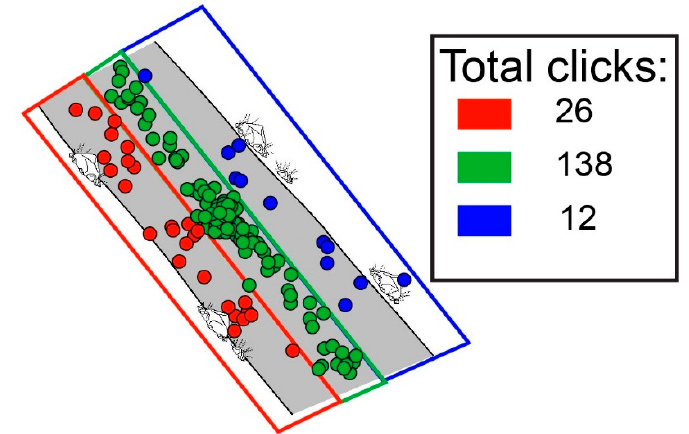
Figure 10. Polygons and student clicks in response to the prompt, “Click in the river where you would find the fastest moving water”. The correct region, labeled in green ( n = 138), is the middle of the river channel. The region labeled in red ( n = 26) and green ( n = 12) will have relatively lower velocity and erosion.